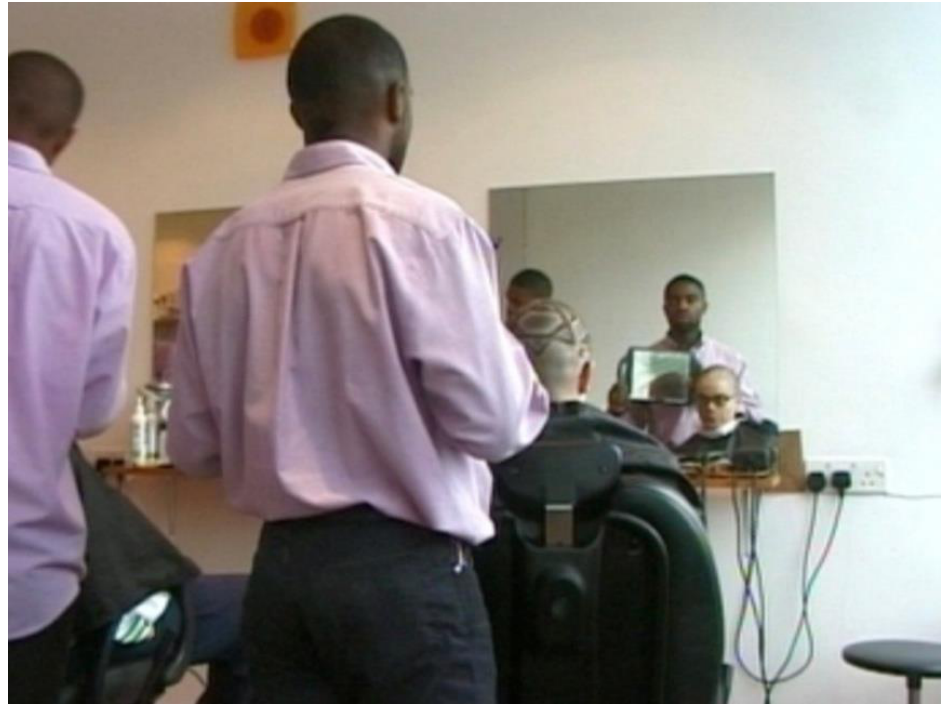
Figure 12. Oreet Ashery, What Is It Like for You? , 2000, 04:06. Video still, 03:09 min. Courtesy of the artist.